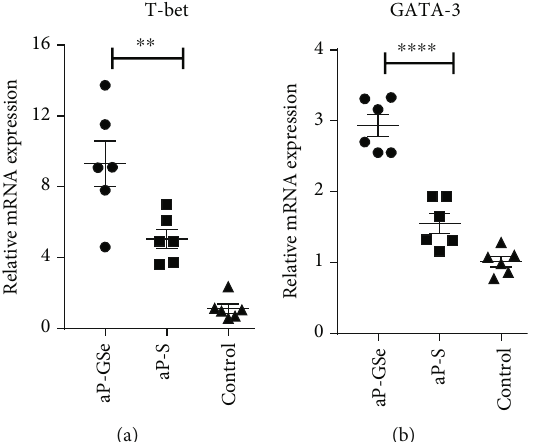
Figure 6: T-bet (a) and GATA-3 (b) mRNA expressed by splenocytes. Mice ( n = 6 /group) received twice i.m. injection of aP-GSe or aP-S at two weeks apart and mice injected with saline served as a control. Splenocytes were prepared 2 weeks after boost immunization and cultured with PrV antigen for 15 h. Fold change of relative mRNA expression of T-bet and GATA-3 was analyzed by RT-qPCR. Data are expressed as the mean ± SE . ∗∗ p < 0 : 01 , ∗∗∗∗ p < 0 : 0001 vs. aP-S group as indicated by one-way ANOVA with the LSD